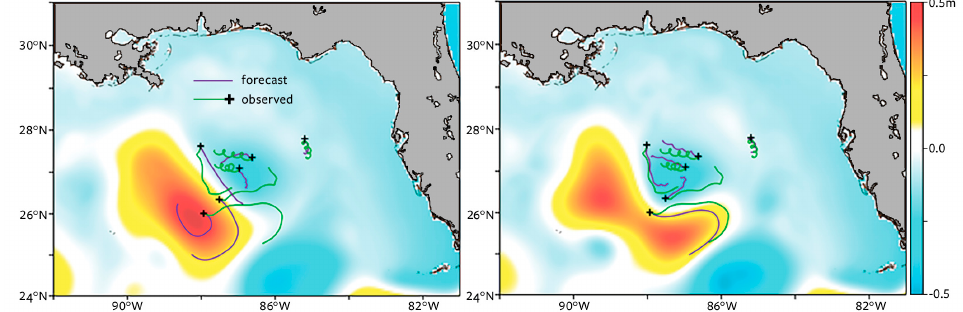
Figure 4. An example of the improved trajectory forecast when the targeted Grand Lagrangian Deployment (GLAD) drifters are used in the assimilation process (from Carrier et al. [68]).